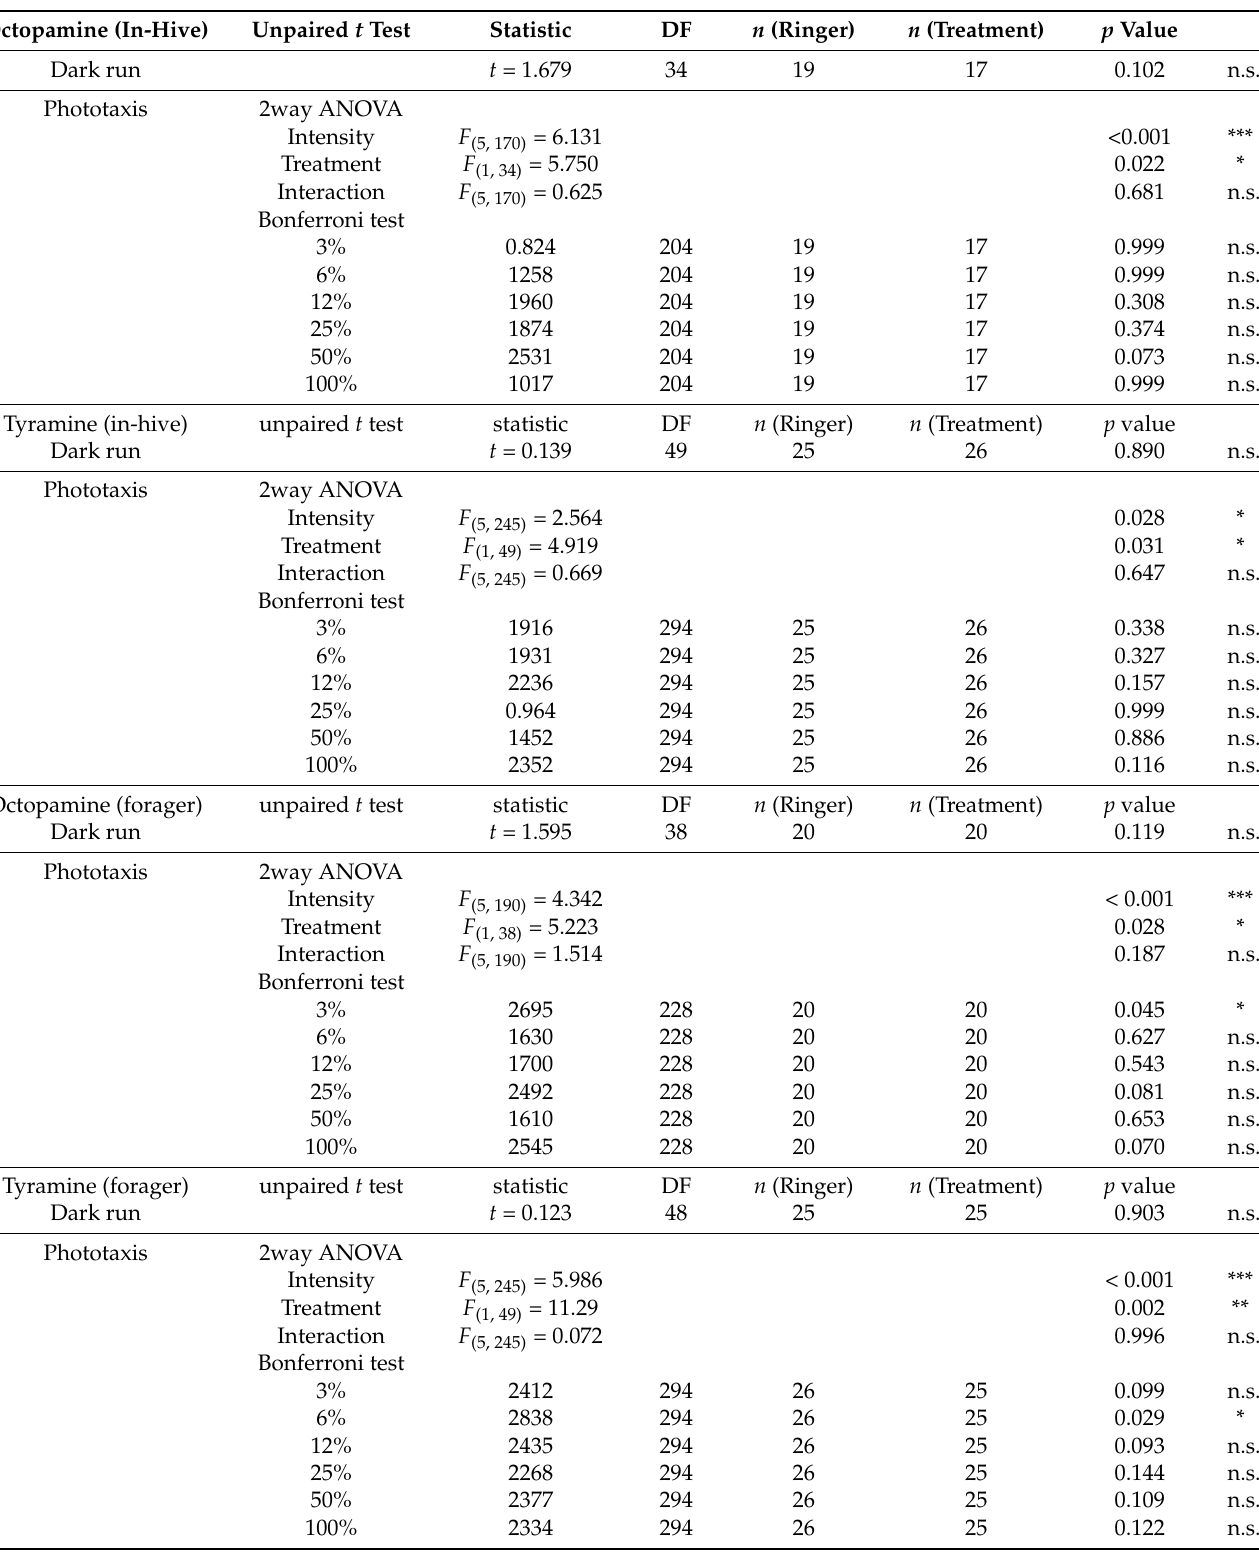
Table 3. Statistical comparison of the dark runs and the phototaxis of honeybees (either in-hive bees or foragers) treated with octopamine/tyramine (treatment) or Ringer